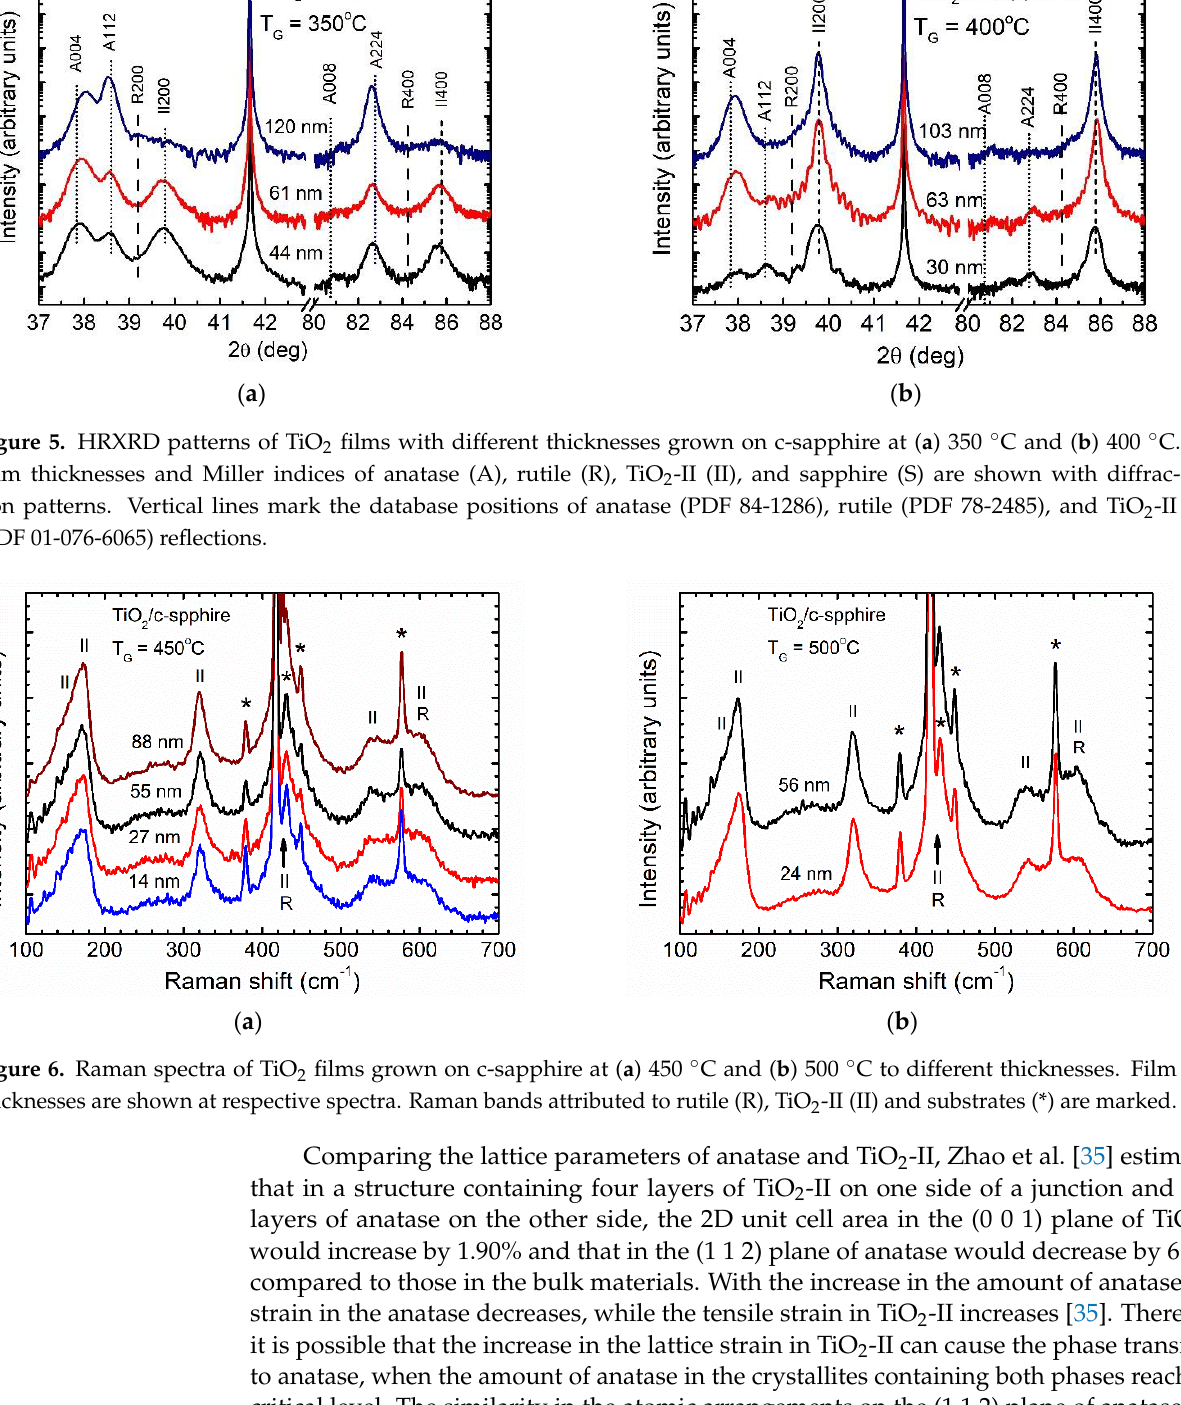
( b ) Figure 4. XRD θ-2θ reflections measured from anatase (1 0 1) planes, TiO 2 -II (1 1 1) planes, and rutile (1 1 0) planes of ( a ) 51-nm and ( b ) 31-nm thick TiO 2 films grown on c-sapphire at ( a ) 300 °C and ( b ) 400 °C. The samples were tilted by χ = 68.3° for anatase, χ = 51.0° for TiO 2 -II, and χ = 43.5° for rutile detection. The results, depicted in Figure 5, confirmed those in Figure 3 and demonstrated that in a T G range of 350–400 °C, the increase of the film thickness on the c-sapphire substrates resulted in a more preferential growth of anatase compared to that of TiO 2 -II and/or rutile. Therefore, the template effect, leading to the growth of the high-density phases, was ex- tended to the relatively small film thicknesses at these temperatures. However, at T G ≥ 450 °C, it was possible to deposit up to 88-nm thick films that were free of anatase inclusions, as proven by the HRXRD patterns (Figure 3b) and Raman spectra (Figures 1c and 6a). Moreover, the Raman studies did not reveal any changes in the TiO 2 -II to rutile concen- tration ratios, when the thicknesses of the films deposited at 450 °C increased from 14 to 88 nm (Figure 6a). In contrast, the thickness increase (from 24 to 56 nm) of the films de- posited on c-sapphire at 500 °C caused an increase in the relative intensity at 600–620 cm – 1 (Figure 6b), where an intense Raman band of rutile was located (Figure 1b,d). Similar changes in the Raman spectra were observed with increasing thickness of the TiO 2 films grown at 500 °C on c-sapphire from TiCl 4 and H 2 O [32]. The increase in the rutile content